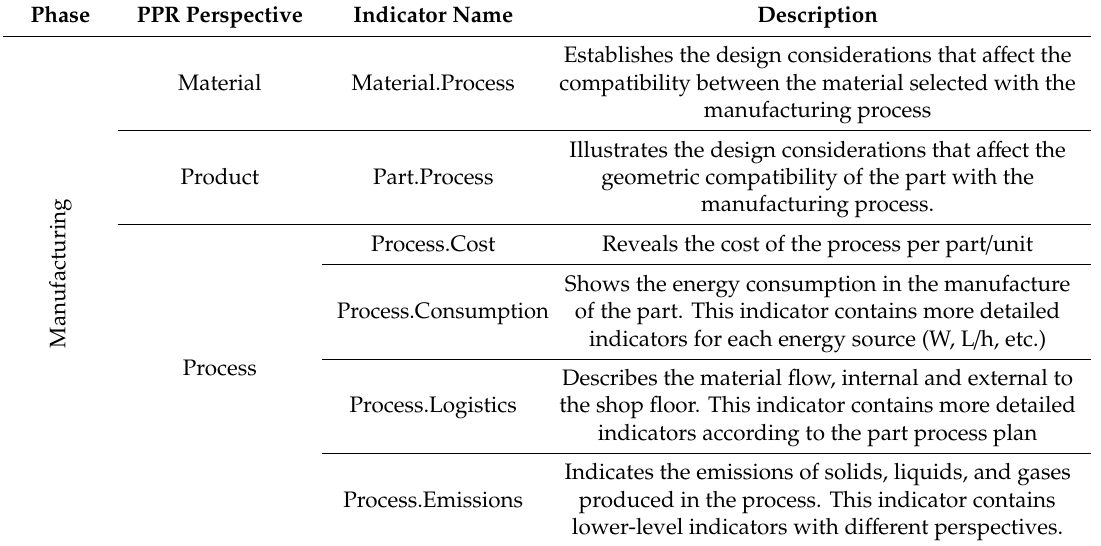
Table 5. Manufacturing phase indicators definition.